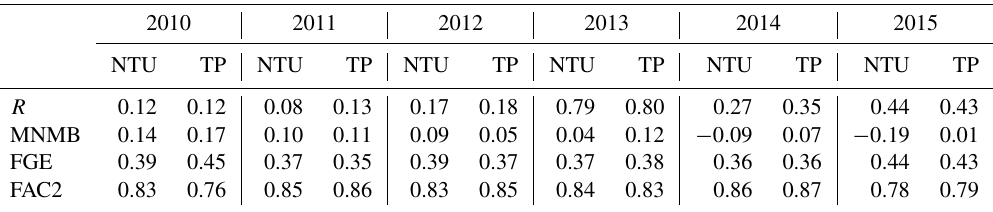
Table 3. Statistics for PM 10 , for both the western (NTU) and eastern (TP) monitoring stations and all years. The background concentration of 25µgm − 3 is subtracted from the observations for all stations for all years. The metrics considered are the Pearson correlation coefficient ( R ), the modified normalised mean bias (MNMB), the fractional gross error (FGE), and a factor of 2 (FAC2).